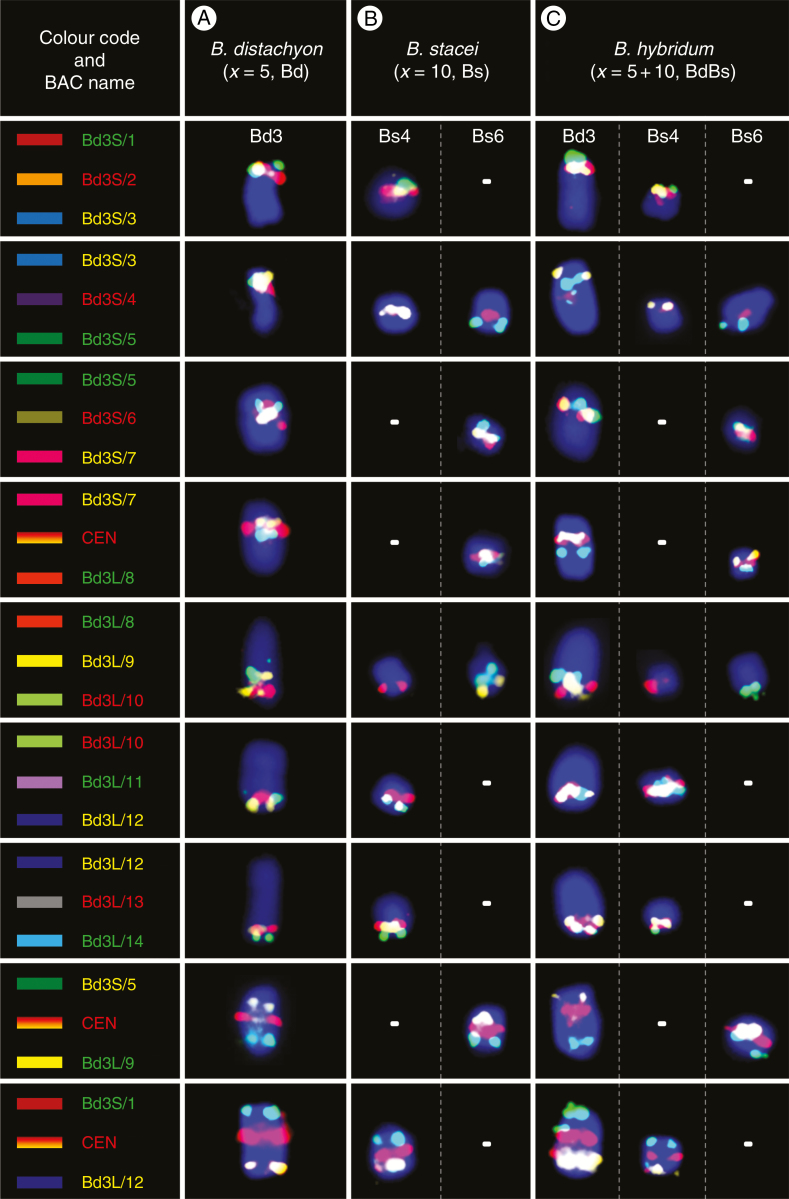
BAC–FISH-based comparative chromosome barcoding with the clones from chromosome Bd3 of B. distachyon (A) to chromosomes Bs4 and Bs6 of B. stacei (B) and Bd3, Bs4 and Bs6 of B. hybridum (C). Only one homologue from a pair is shown. The BAC name text labels in the first column indicate the fluorochrome that was used (green, FITC; red, tetramethylrhodamine; yellow [false colour], Alexa Fluor 647). The chromosomes were stained with DAPI (blue). The coloured bars on the left and BAC names that were assigned to specific clones correspond to those on the cytogenetic maps in Fig. 5.